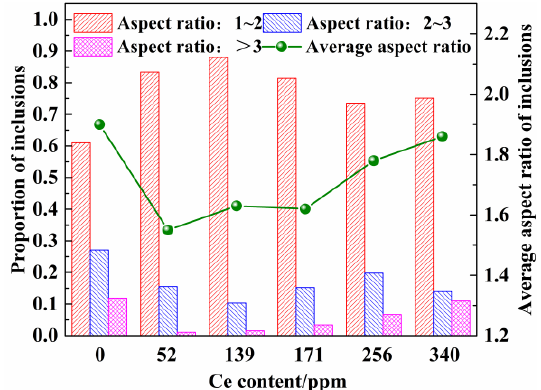
Figure 8. Aspect ratio of inclusions.